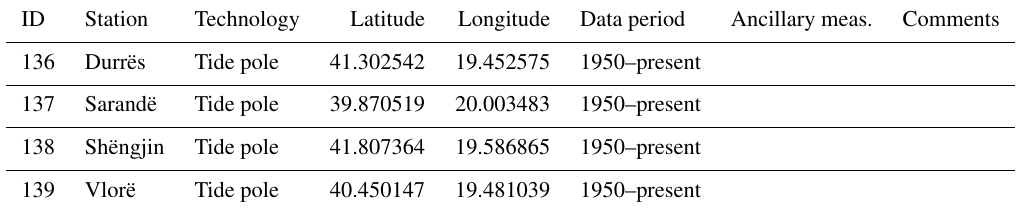
Table A14. Tide gauge stations in Albania, operated by the Institute of Geoscience.